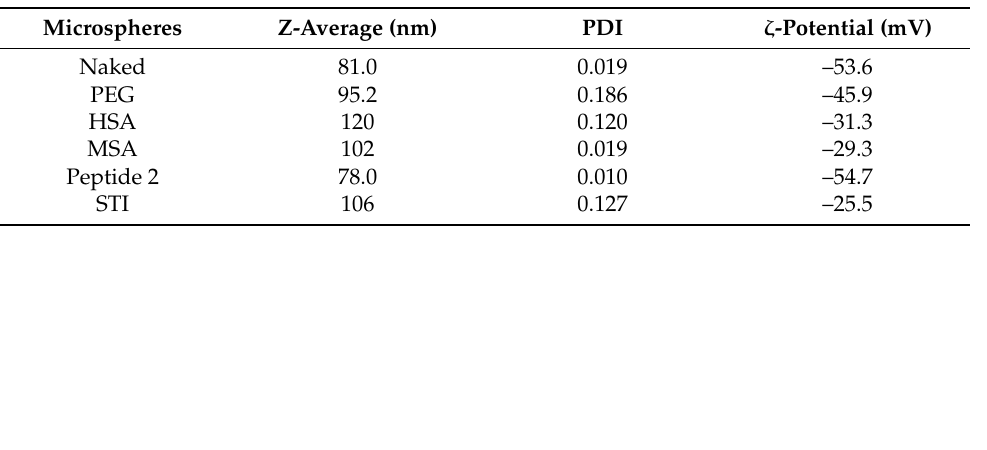
Table 3. Sizes and surface charges of surface-modified